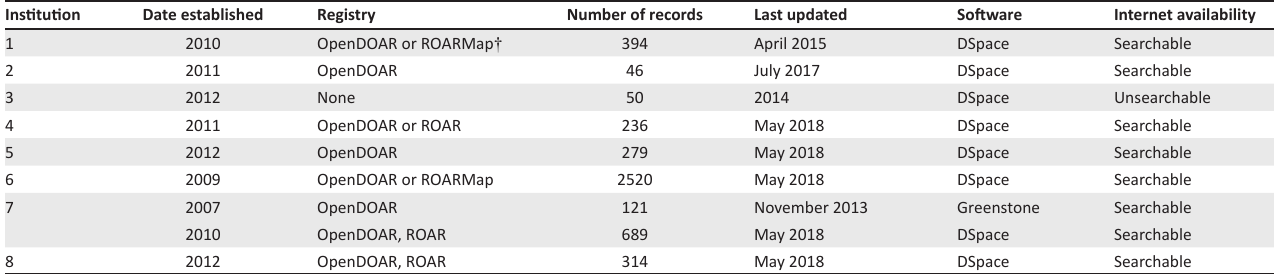
TABLE 3: Official institutional repositories of eight public universities.